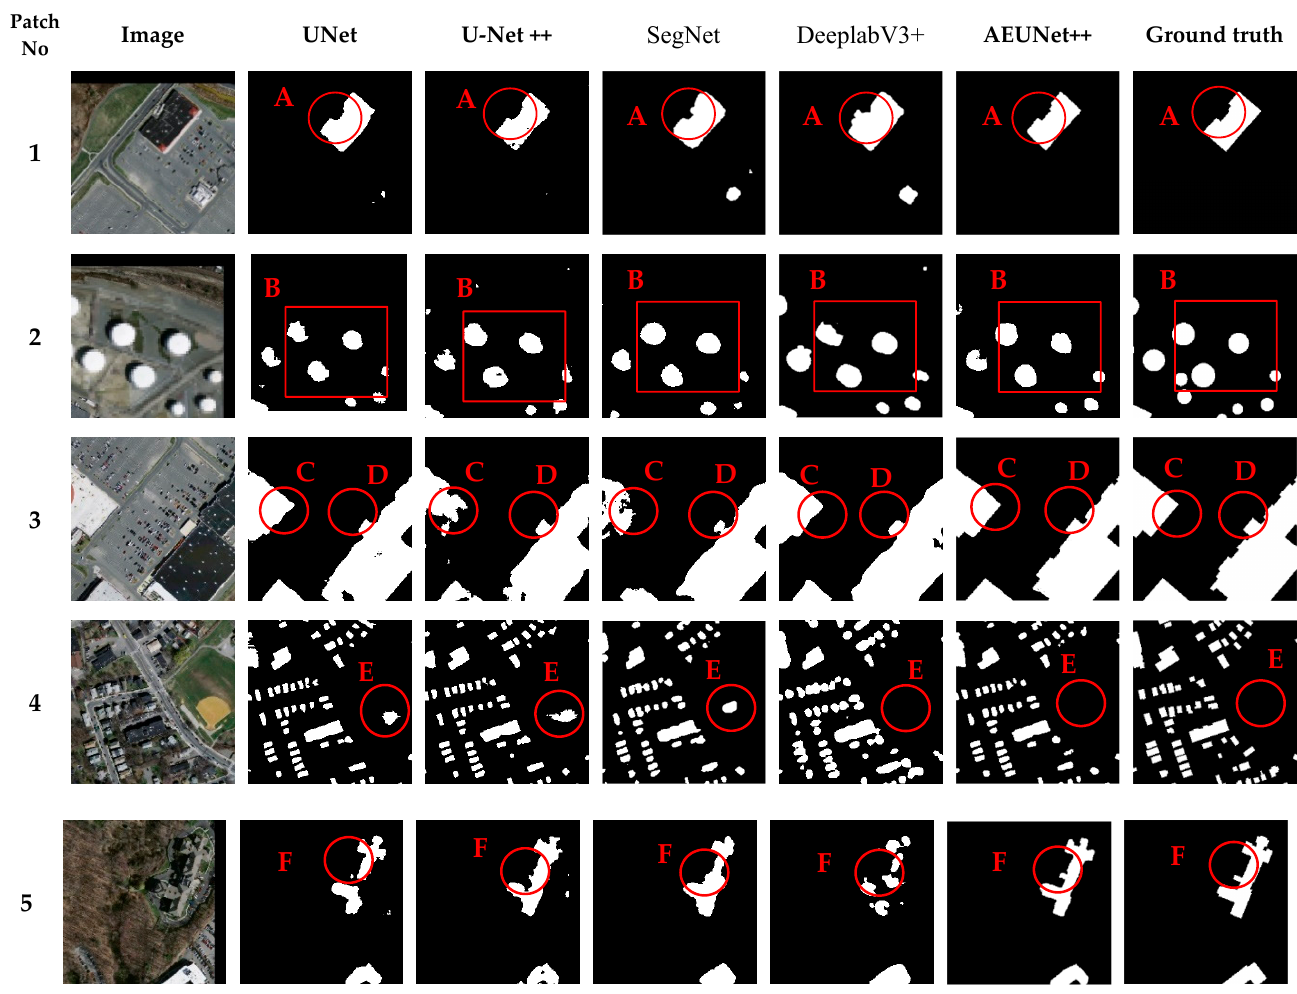
Figure 9. Segmented patches from U-Net, UNet++, SegNet, DeeplabV3+ and AEUNet++ based on the Massachusetts buildings dataset. The white color in the segmented patches represents pixels belonging to buildings (A–F denote the marked areas). Table 1. Quantitative comparison of OA, Precision, Recall, F1, IoU and mIoU for the Massachusetts buildings data